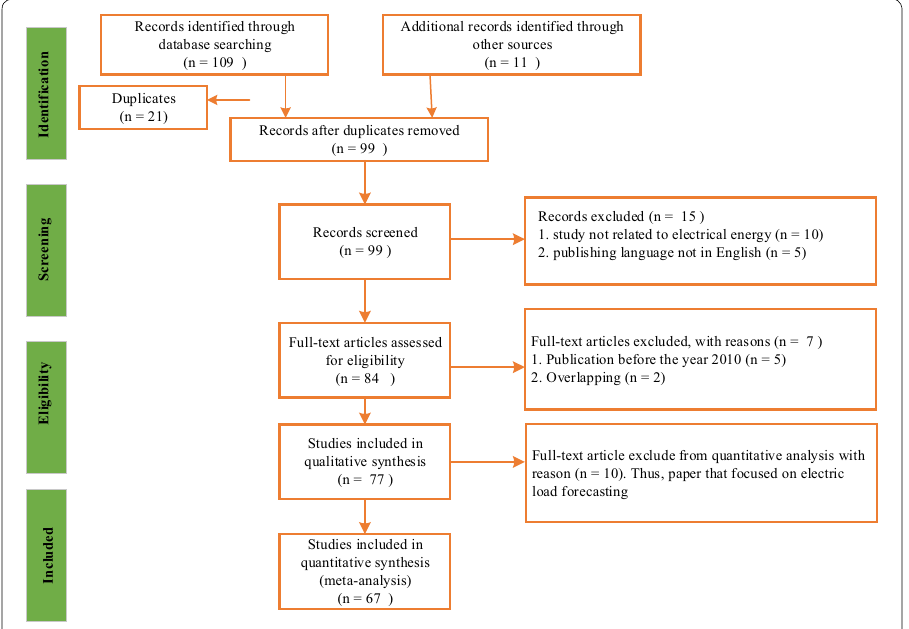
Fig. 1 The adopted PRISMA flow diagram. Source : Moher et al.